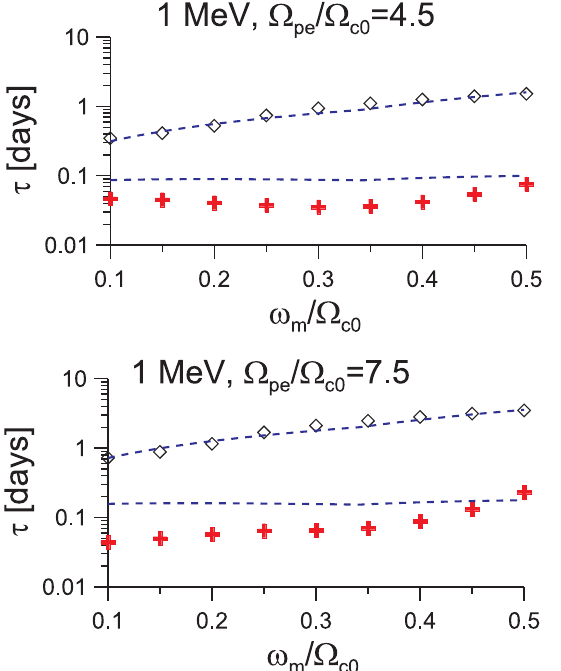
Fig. 15. Electron lifetimes for two values of ratio (cid:127) pe /(cid:127) c0 , for quasi-parallel (diamonds) and oblique (red crosses) chorus waves. Full numerical solutions as well as the corresponding analytical es- timates in Eqs. (9) and (12) are displayed as a function of mean frequency ω m .